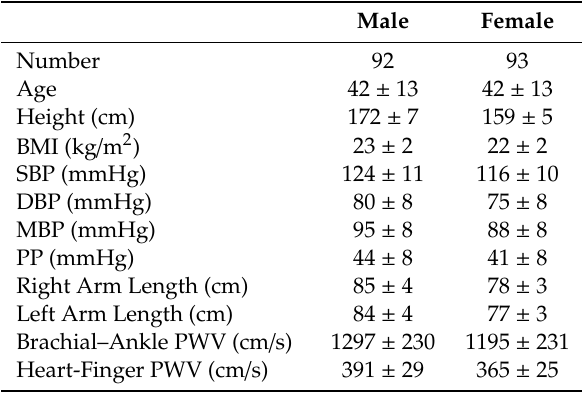
Table 1. Characteristics of all subjects (n = 185). (BMI: body mass index, SBP: systolic blood pressure, DBP: diastolic blood pressure, MBP: mean blood pressure, PP: pulse pressure, baPWV: brachial–ankle pulse wave